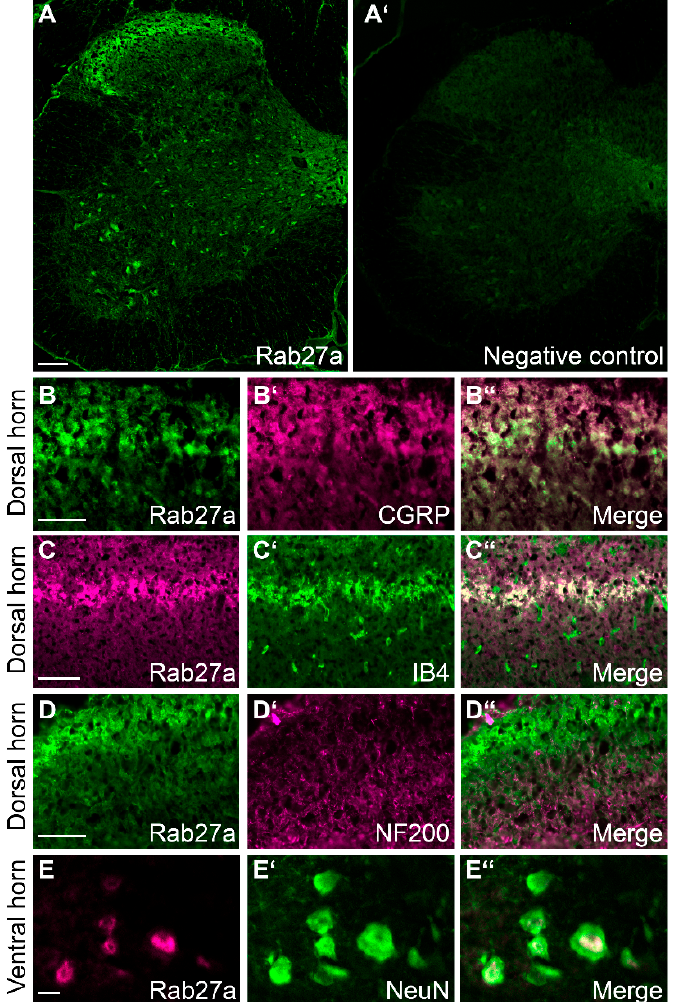
Figure 2. Rab27a localization in the spinal cord. ( A ) Immunostaining experiments detected Rab27a in the dorsal horn and in some ventral horn neurons. No specific signal was detected by omitting the primary antibody (A’, negative control). ( B–D ’’) Double immunolabeling experiments with established markers revealed that Rab27a colocalizes with calcitonin gene ‐ related peptide (CGRP) ( B–